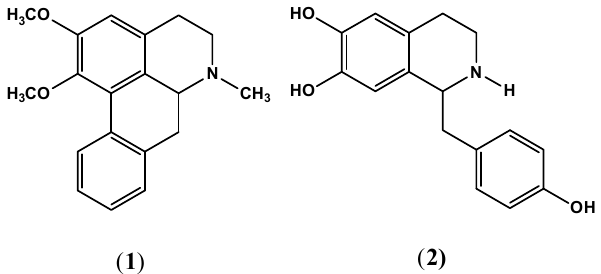
Figure 1. Nuciferine ( 1 ) and norcoclaurine ( 2 ) isolated from the seeds of N. nucifera.